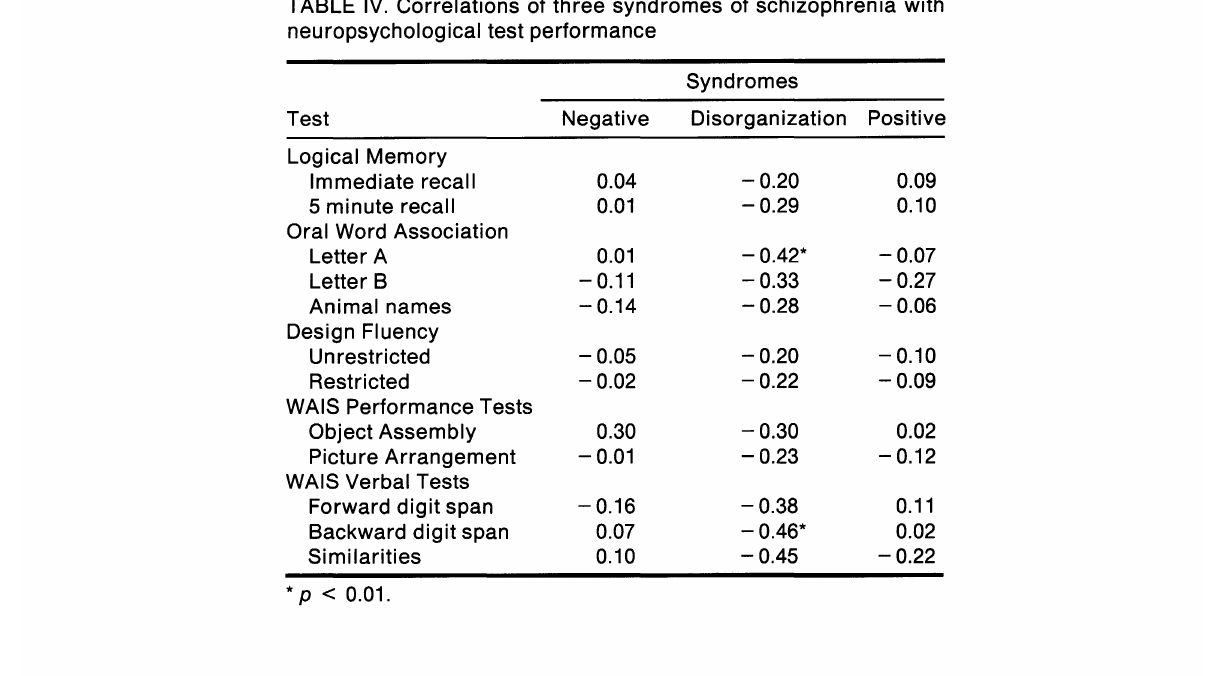
TABLE IV. Correlations of three syndromes of schizophrenia with neuropsychological test